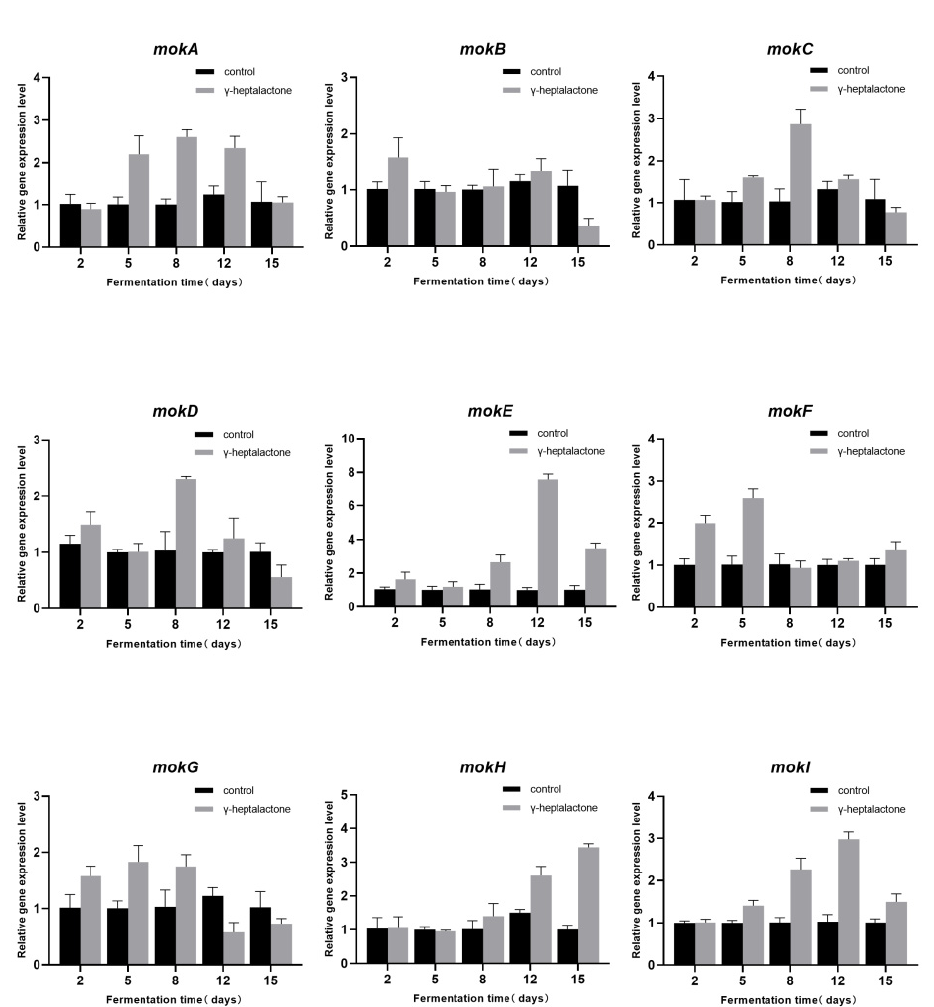
Figure 4. Effect of γ -heptalactone on the relative expression levels of MK biosynthesis genes ( mokA – I ).